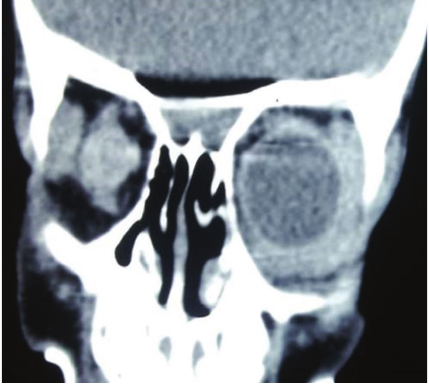
Figure 1: Phthisical right eye.